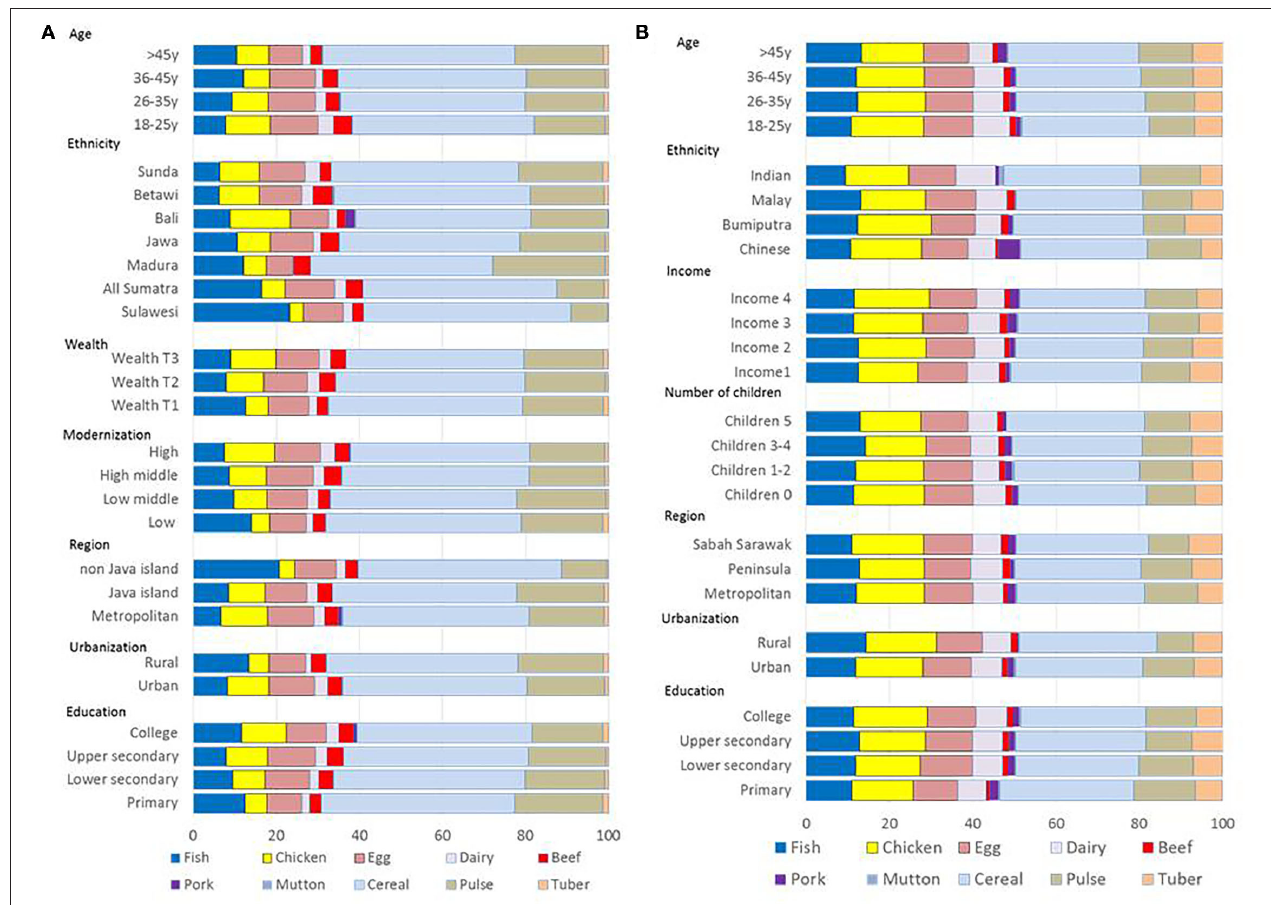
FIGURE 2 | Percent frequencies of protein consumption by food source for Indonesia (A) and Malaysia (B). Data for population subgroups by demographic variables. Malaysia data based on Drewnowski et al. ( 1).